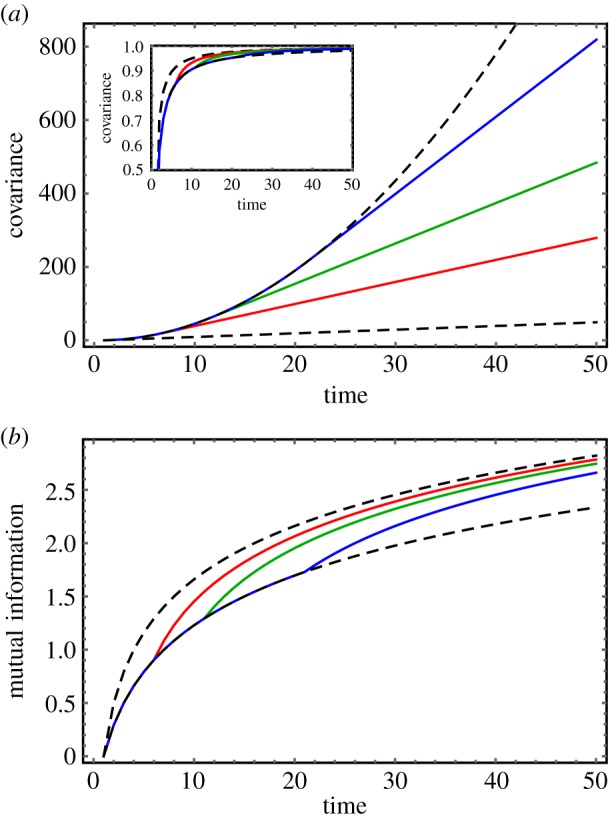
Covariance versus mutual information. (a) cov(Xn(t), Xn(t − 1)) for the ant model with n = 5 (red), 10 (green) and 20 (blue). The bottom dashed curve is the covariance for n = 0 (the lead ant), which serves as a lower bound. The upper dashed curve is the common curve that each covariance obeys for 0 < t ≤ n. (b) MI(Xn(t); Xn(t − 1)) in units of bits for the same set of values of n. The order of the curves here is reversed, with the n = 0 curve now serving as an upper bound. The inset of (a) shows that the same ordering can be achieved with the covariance if it is normalized by the product of the standard deviations in Xn(t) and Xn(t − 1), but at the cost of compressing the curves to the unit interval.